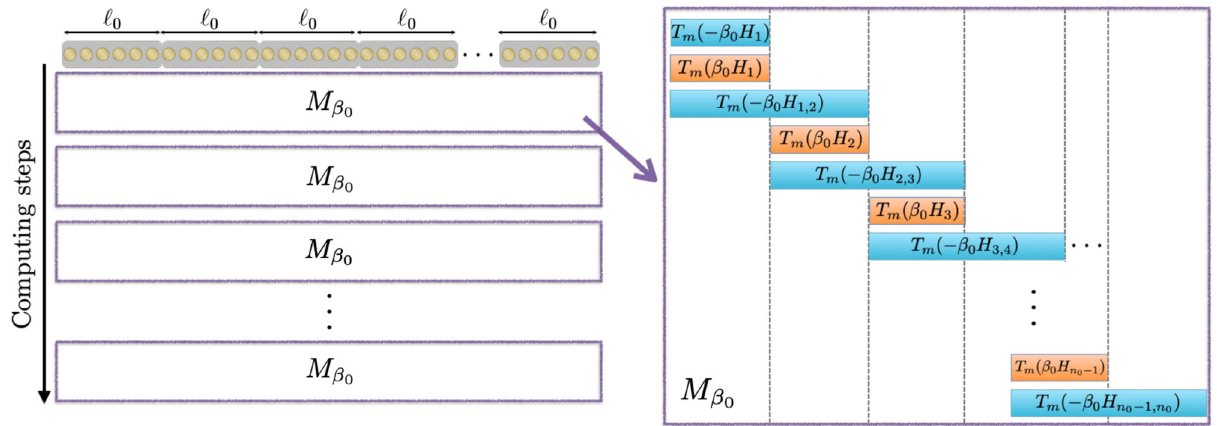
FIG. 4. Our algorithm proceeds by iterated approximations of e − β 0 H , performed β = β 0 times. In each step, we approximate the Gibbs operator e − β 0 H by the operator M β . For this approximation, we establish a decomposition of e − β 0 H as a product of operators shown on 0 the right-hand side. This decomposition uses an imaginary-time version of the Lieb-Robinson bound and the Taylor truncation of the exponential